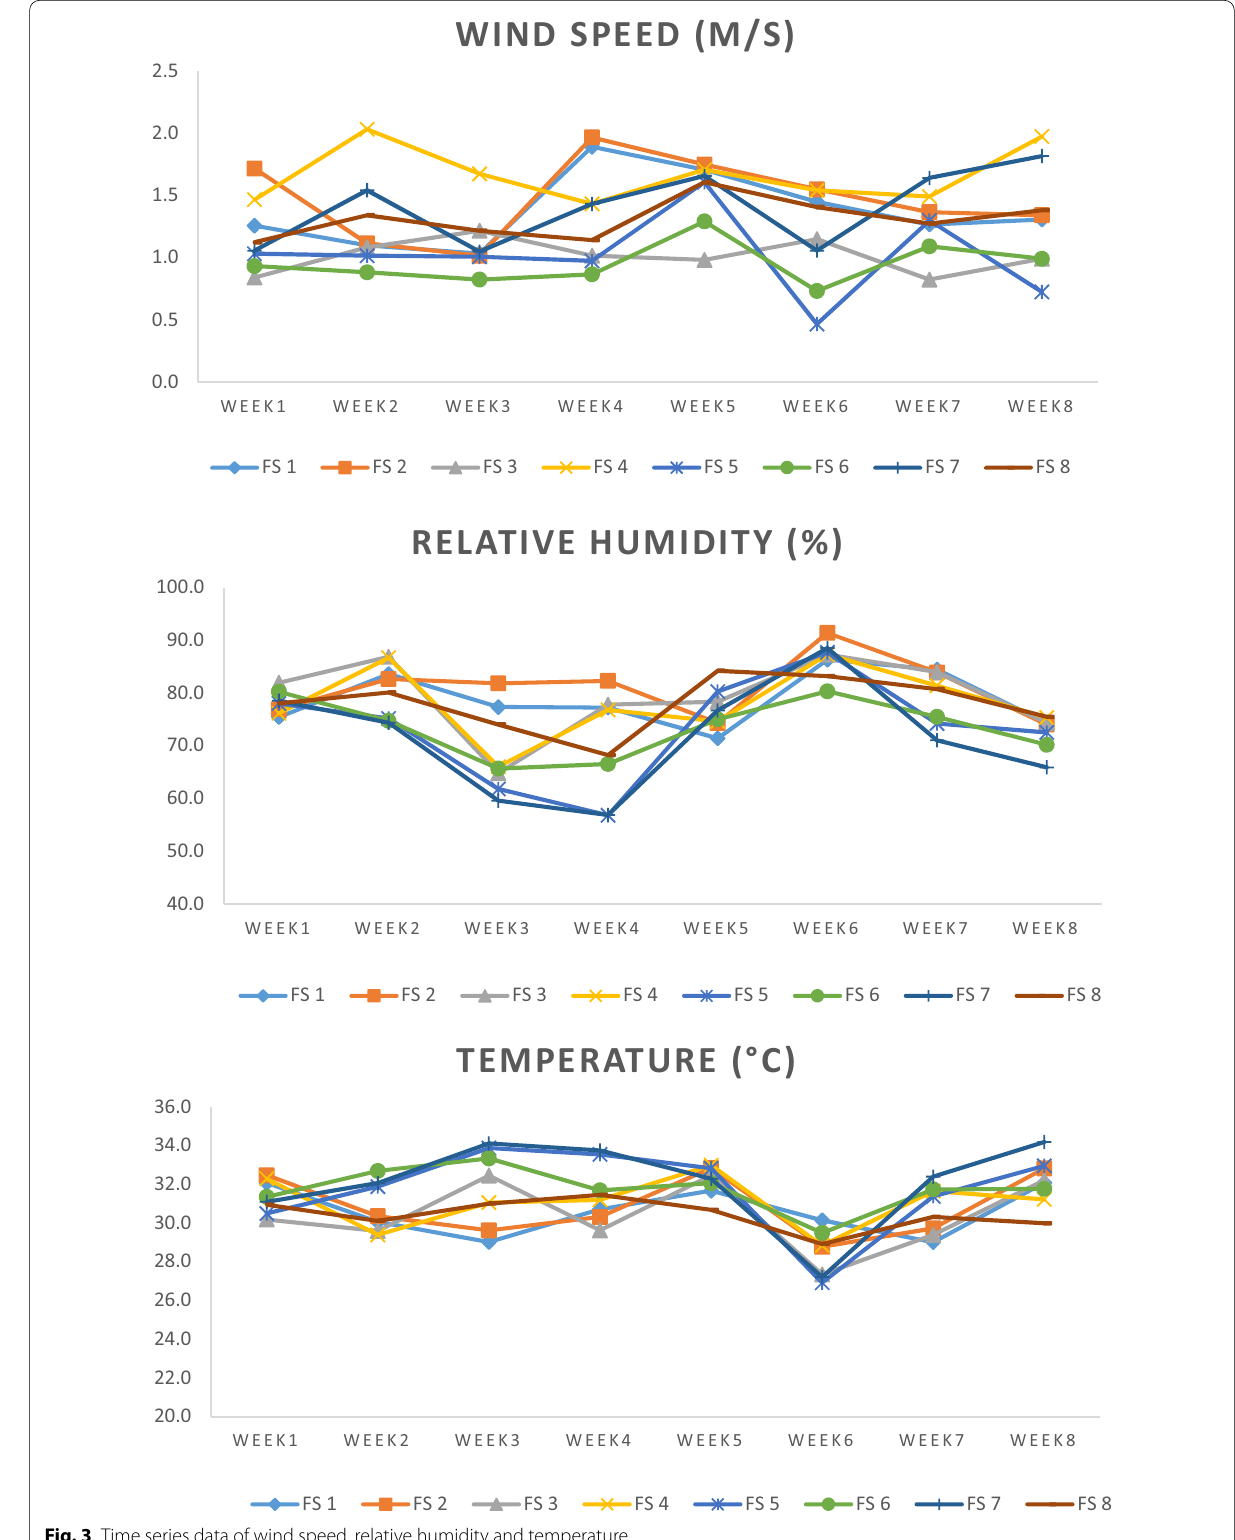
Fig. 3 Time series data of wind speed, relative humidity and